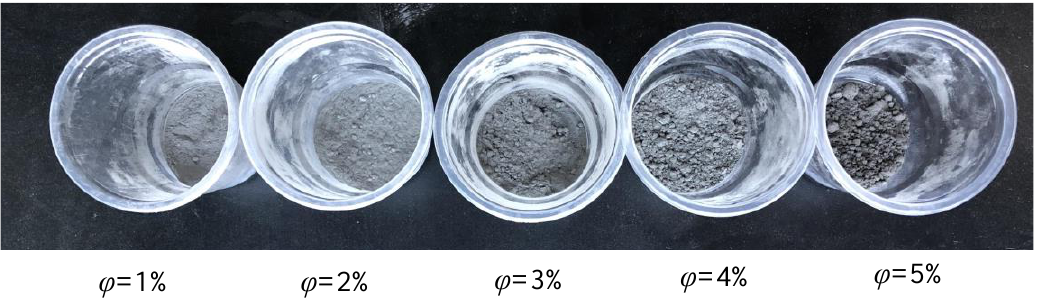
Figure 9. Dust particles with different moisture contents.